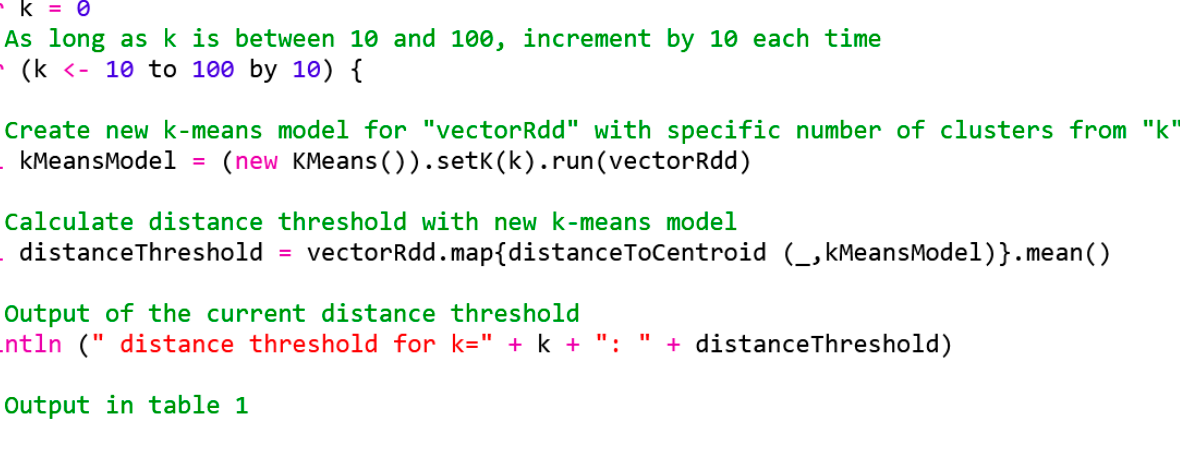
Figure 13. Calculation of the distance thresholds for different k-means models. Table 1. Distance thresholds with values for k between 10 and 100.